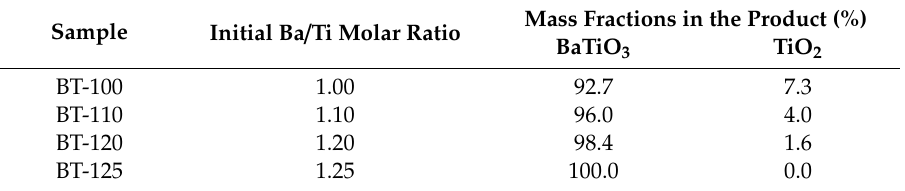
Figure 1. XRD patterns of BaTiO 3 powders synthesized at 200 ◦ C, 1.55 MPa over 20 h. in water vapor with the use of different Ba/Ti molar ratio (BT) in the reaction mixture (indicated). The powders were washed with acetic acid solution and distilled water after the synthesis. * asterisk indicated peaks correspond to BaTiO 3 (PDF-2 No. 00-031-0174), arrow indicated peaks correspond to TiO 2 (rutile, PDF-2 No. 00-021-1276). Table 1. Ba/Ti molar ratio in the reaction mixture and phase composition of the synthesized powders after Ba 2+ excess removal.